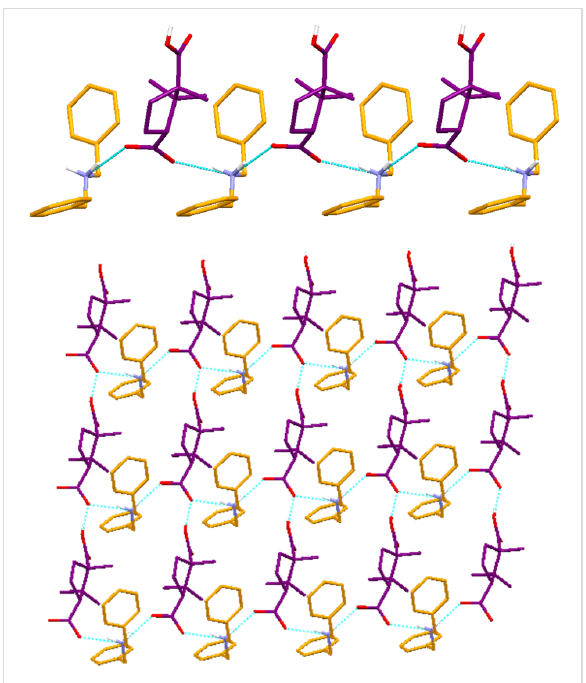
Figure 6: Crystal structure illustrations of DBAMC 6 ; top – propaga- tion 1-D network involving ammonium and carboxylate ions; bottom – overall 2-D hydrogen bonded network.